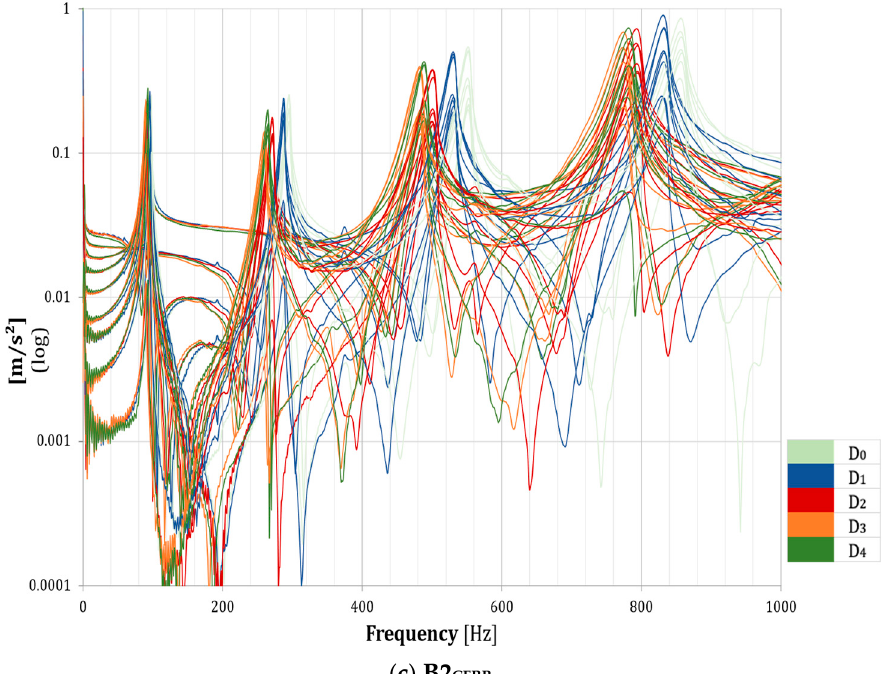
Figure 13. Envelope of FRFs for damage degree D i for each RC beam: ( a ) specimen B1, ( b ) specimen B1 GFRP ; and ( c ) specimen B2 CFRP .